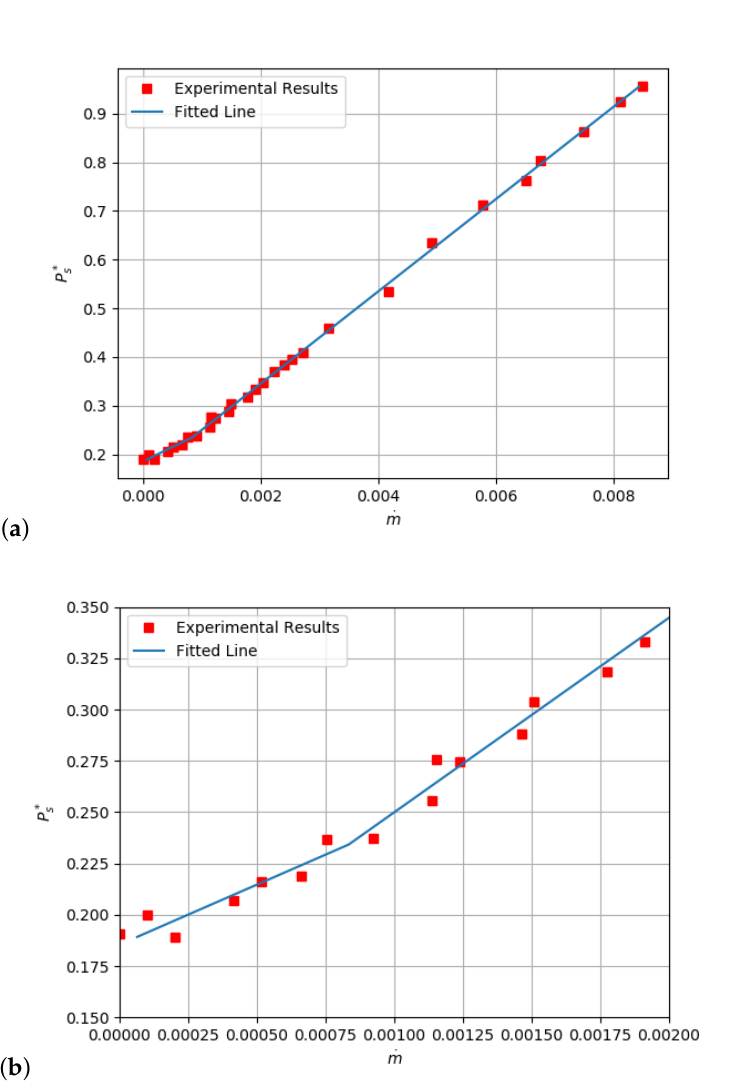
Figure 9. ( a ) Piecewise linear composition of performance function; ( b ) Detail of the